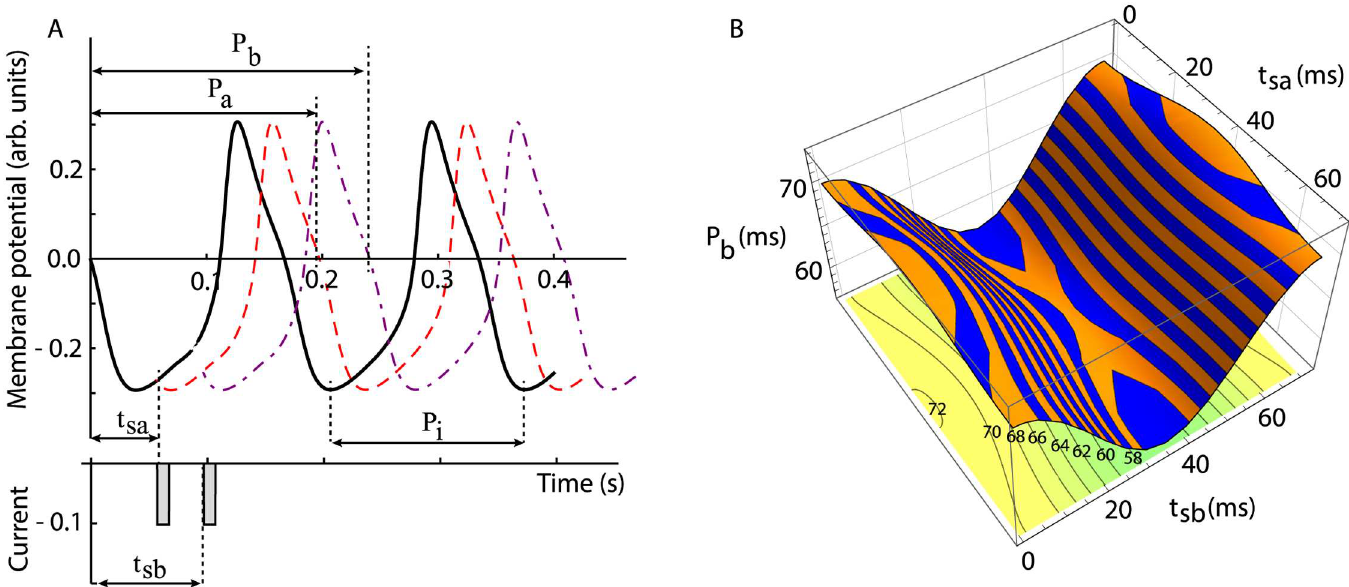
Fig 2. Typical two stimuli PRC. ( A ) Two brief stimuli delivered at stimulus times t sa and, respectively, t sb . The first stimulus transiently modifies the intrinsic firing period P i to a new value P a = P i (1 + F (1) ( φ a )), where φ a = t sa / P i . The second stimulus arrived at a new phase φ b = t ab / P a that found a modifiedfiring period P a and, therefore, further reset the firing periodto P b = P a (1 + F (1) ( φ b )). ( B ) A typical two stimuli phaseresponsesurface for a class I excitable cell.